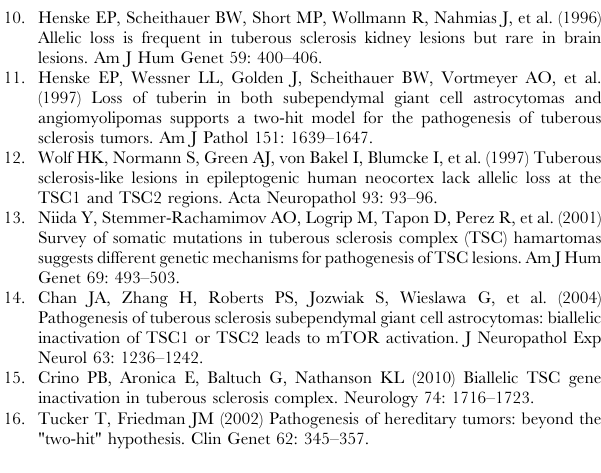
Figure S5 shRNA-assisted TSC1 knock down hinders mTORC2 dependent regulation of FoxO1/3 in trans- formed Jurkat T cells. Jurkat T-leukemia cells were transduced by lentiviral-encoding TSC1 shRNA or scrambled control GFP- tagged shRNA. Cells were selected for 4 days in Puromycin. By then, no viable cells could be recovered from untransduced Puromycin-treated cells. Viable transduced cells separated on a Ficoll gradient, counted and re-plated in fresh complete medium.